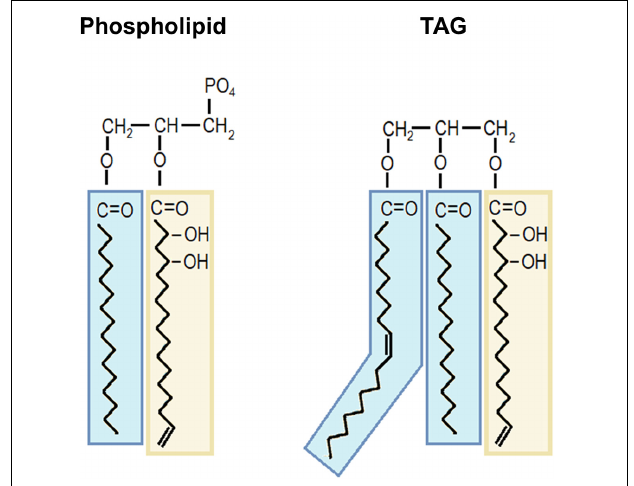
FIGURE 8 | Proposed models of acetogenin moiety within polar lipids and triacylglycerols. A deacetylated acetogenin is depicted bound to a phospholipid as an example of polar lipid and to a TAG molecule. Avocadene backbone is shown as an acetogenin moiety example in yellow squares. Fatty acids are shown in blue squares. TAG,